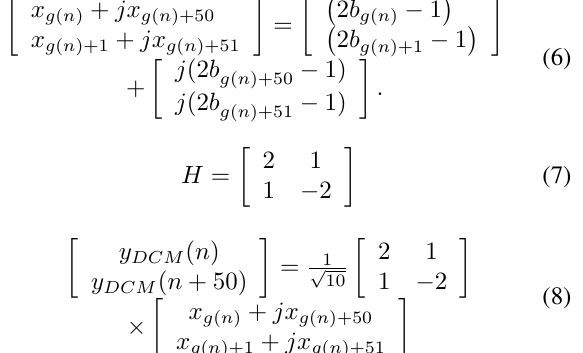
x [ g ( n )] + j x [ g ( n ) + 50] , x [ g ( n ) + 1] + j x [ g ( n ) + 51] are the two QPSK symbols formed by each set of four binary bits. The DCM modulation is then utilizes a matrix H to construct the two DCM symbols from of the two QPSK symbols which are combined to produce two 16QAM [39] as given in Equations (6) , (7) and (8) .